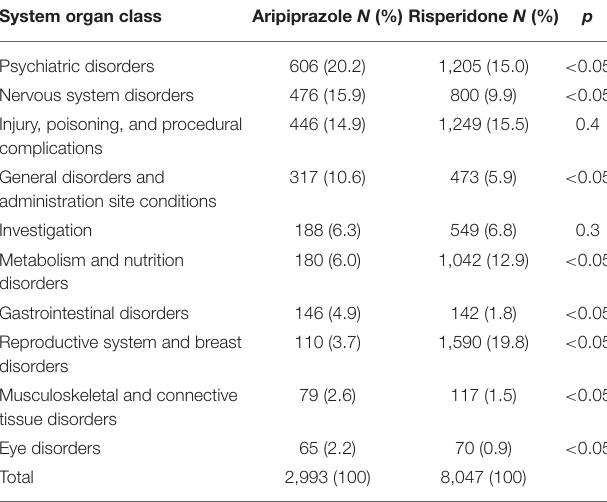
TABLE 4 | Distribution of adverse drug events (AE) categorized according to the system organ classes (SOCs) and involving aripiprazole or risperidone as suspected drugs recognized in EudraVigilance spontaneous reporting system from 2016 to 2018 in pediatric population (3–17 years).